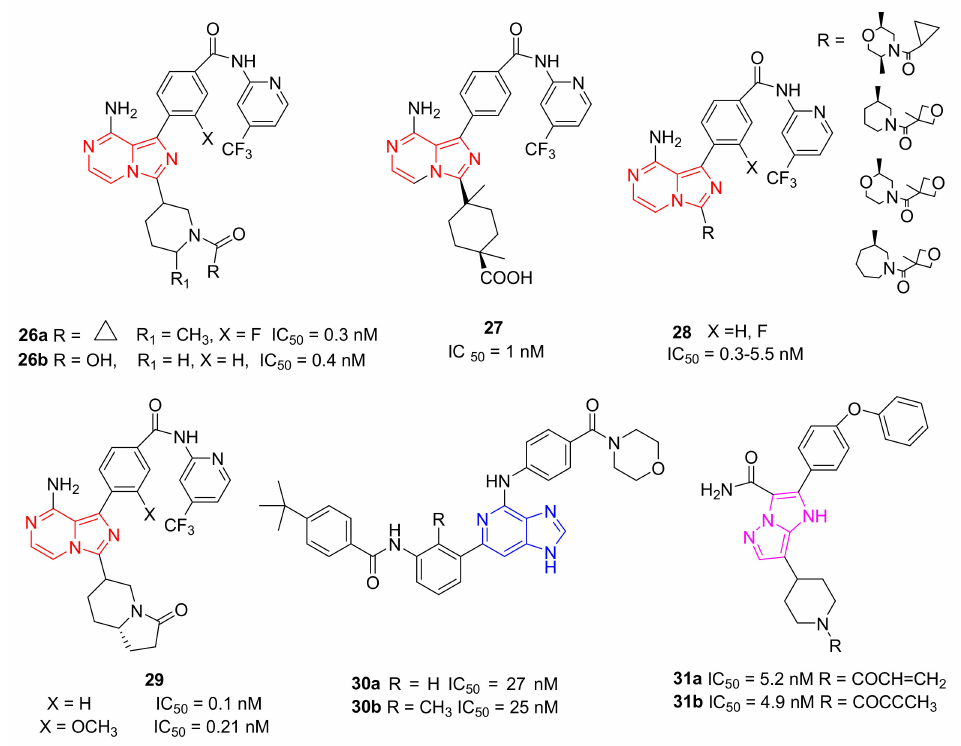
Figure 9. Imidazo-pyrazine, imidazo-pyridine and imidazo-pyrazole